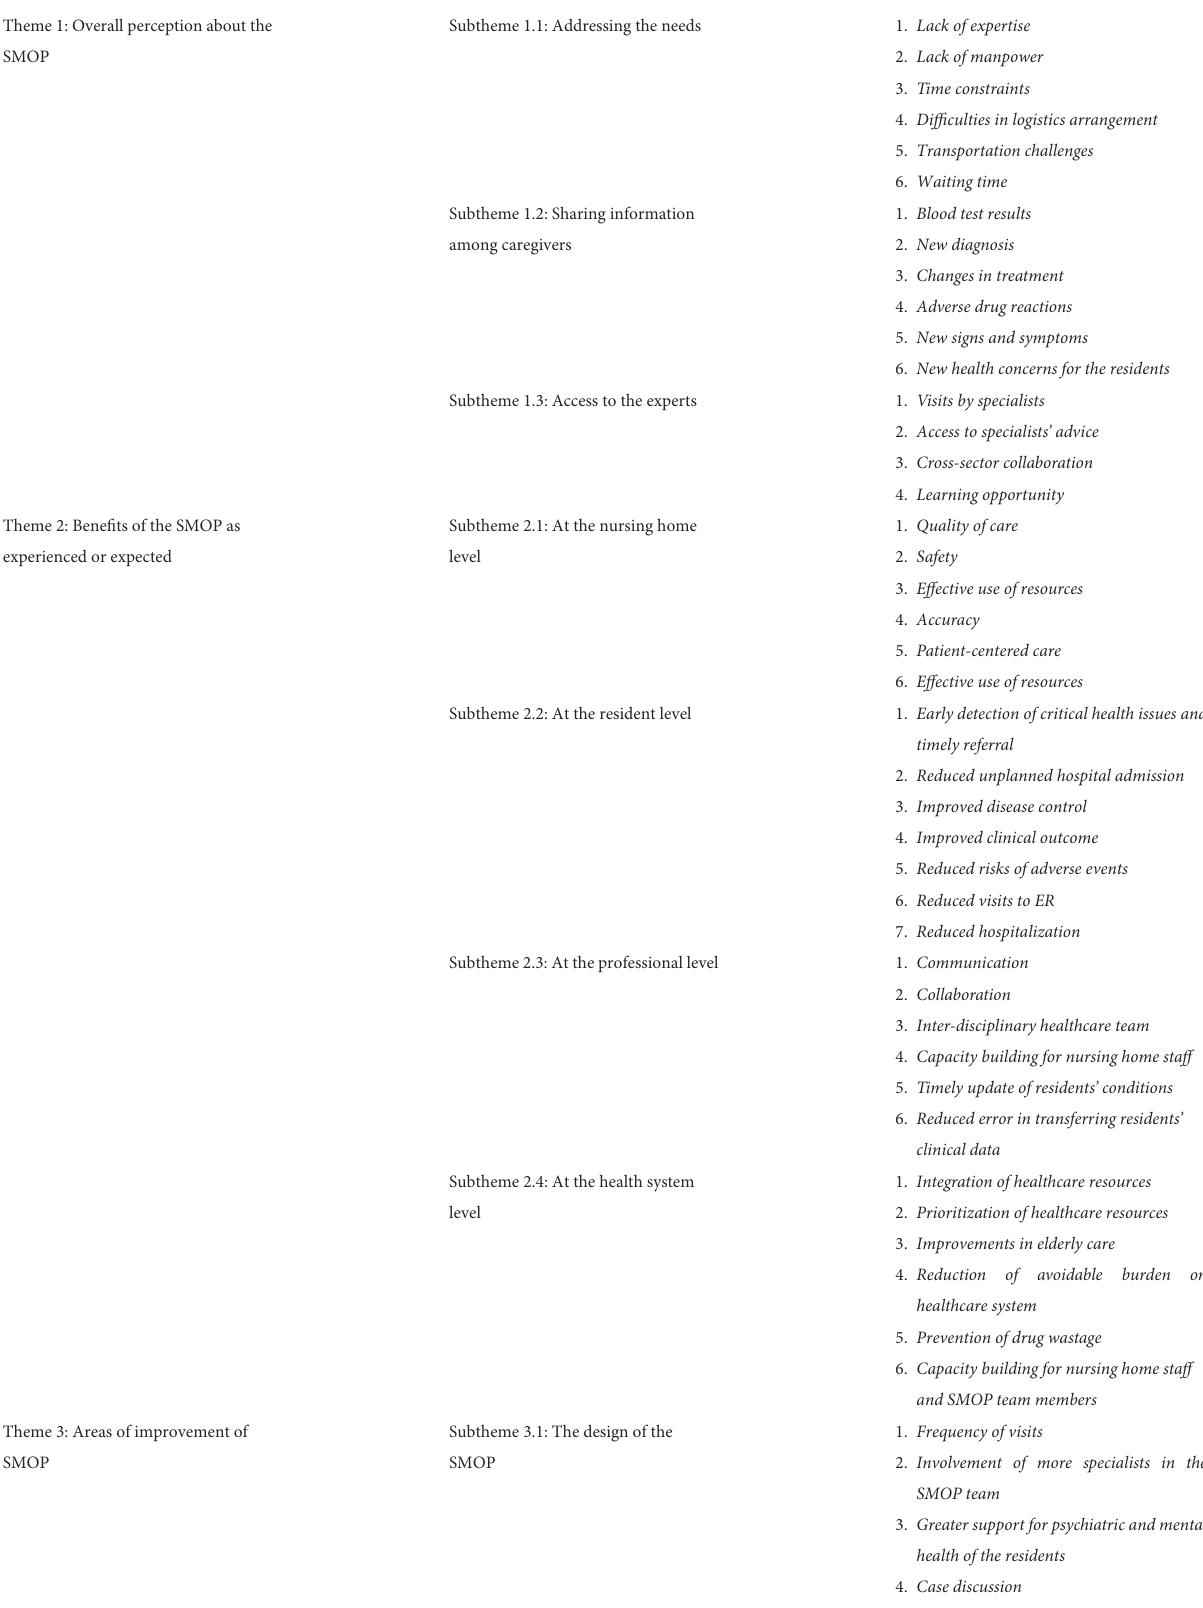
TABLE 2 Thematic analysis of the qualitative